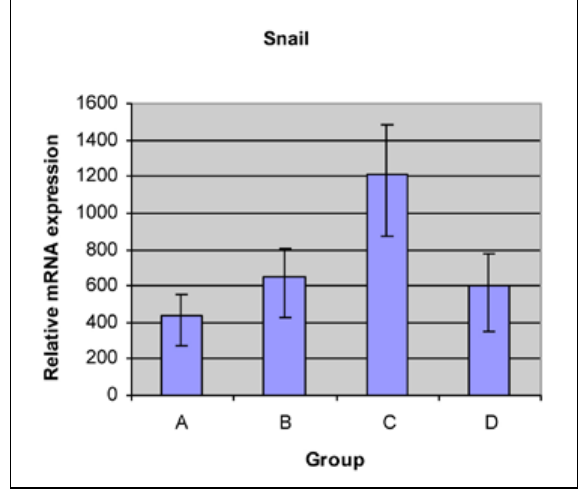
Figure 4. Expression of Slug by human embryonic stem cells – Day 8 (NS p < 0.05). * p < 0.05, reflecting a significant difference between the means of the groups.